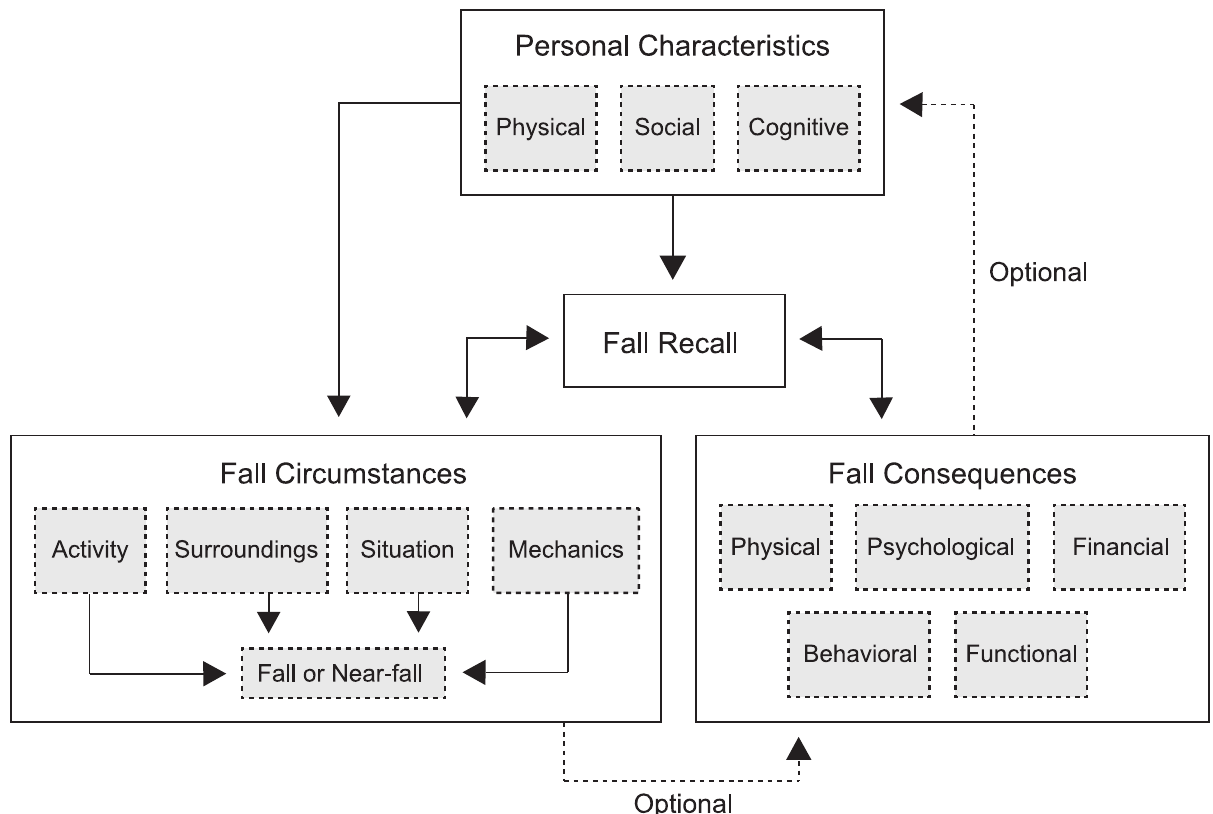
Fig 2. Conceptual framework of fall events in lower limb prosthesis users. The conceptual framework was used to identify, select, and test questions in the fall event survey that are relevant to LLP